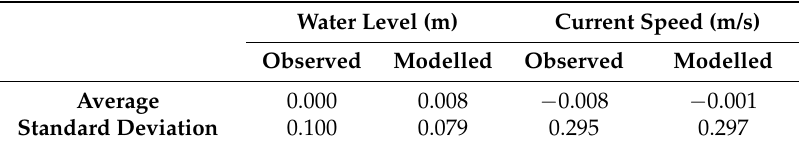
Table 2. Average values and standard deviation between field data and model results during the simulation